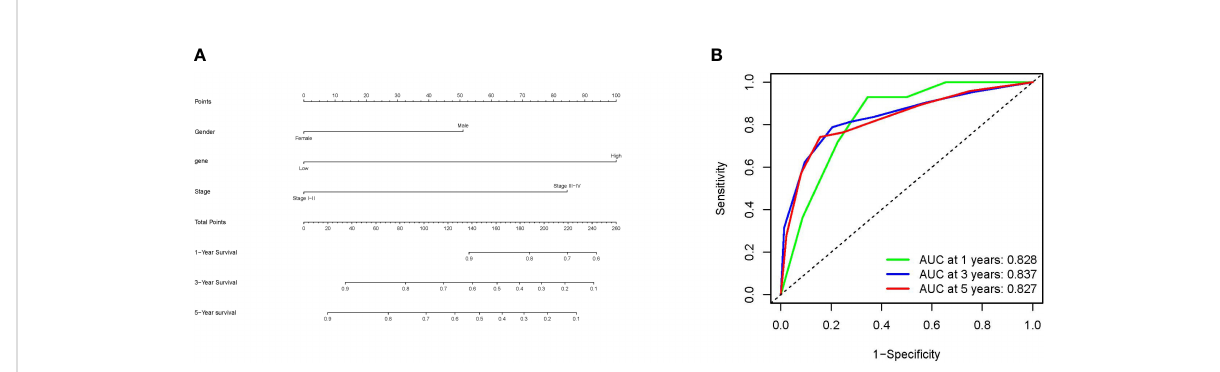
FIGURE 7 Nomogram and its AUC. (A) A prognostic nomogram predicting 1-, 2-, and 3-year overall survival of Wilms tumor patient. (B) ROC curve for 1-, 3-, and 5-year overall survival predictions for the